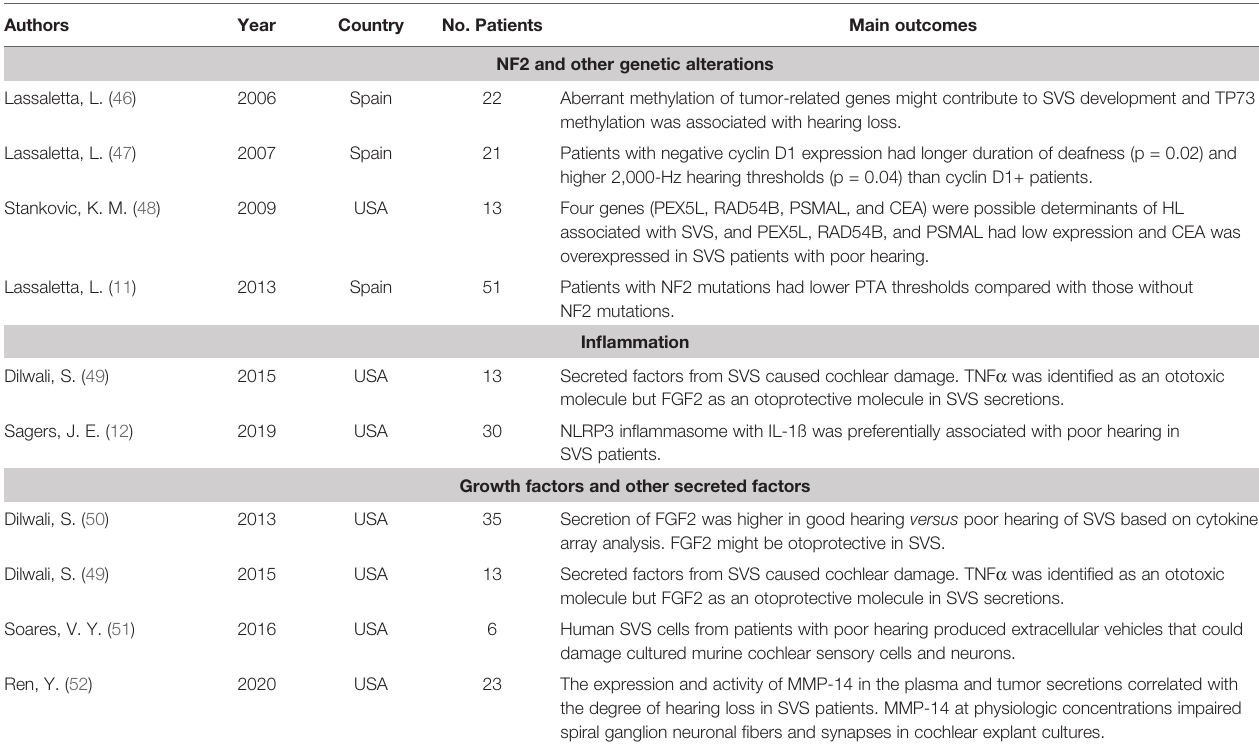
TABLE 5 | The summarization of literature regarding the molecular and genetic change in SVS-associated hearing loss. Authors